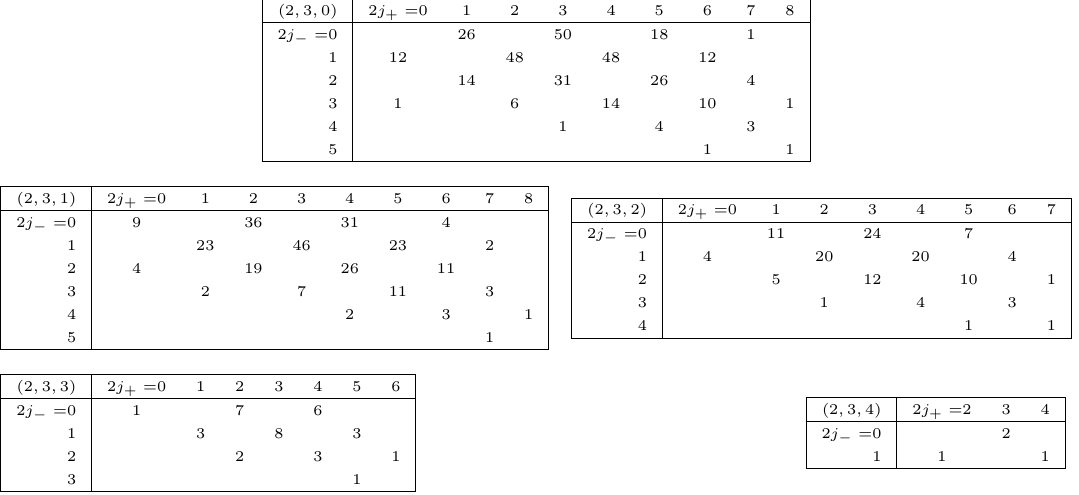
Table 16 . BPS numbers of massive M-string with base degree 2 and fiber degree 3.